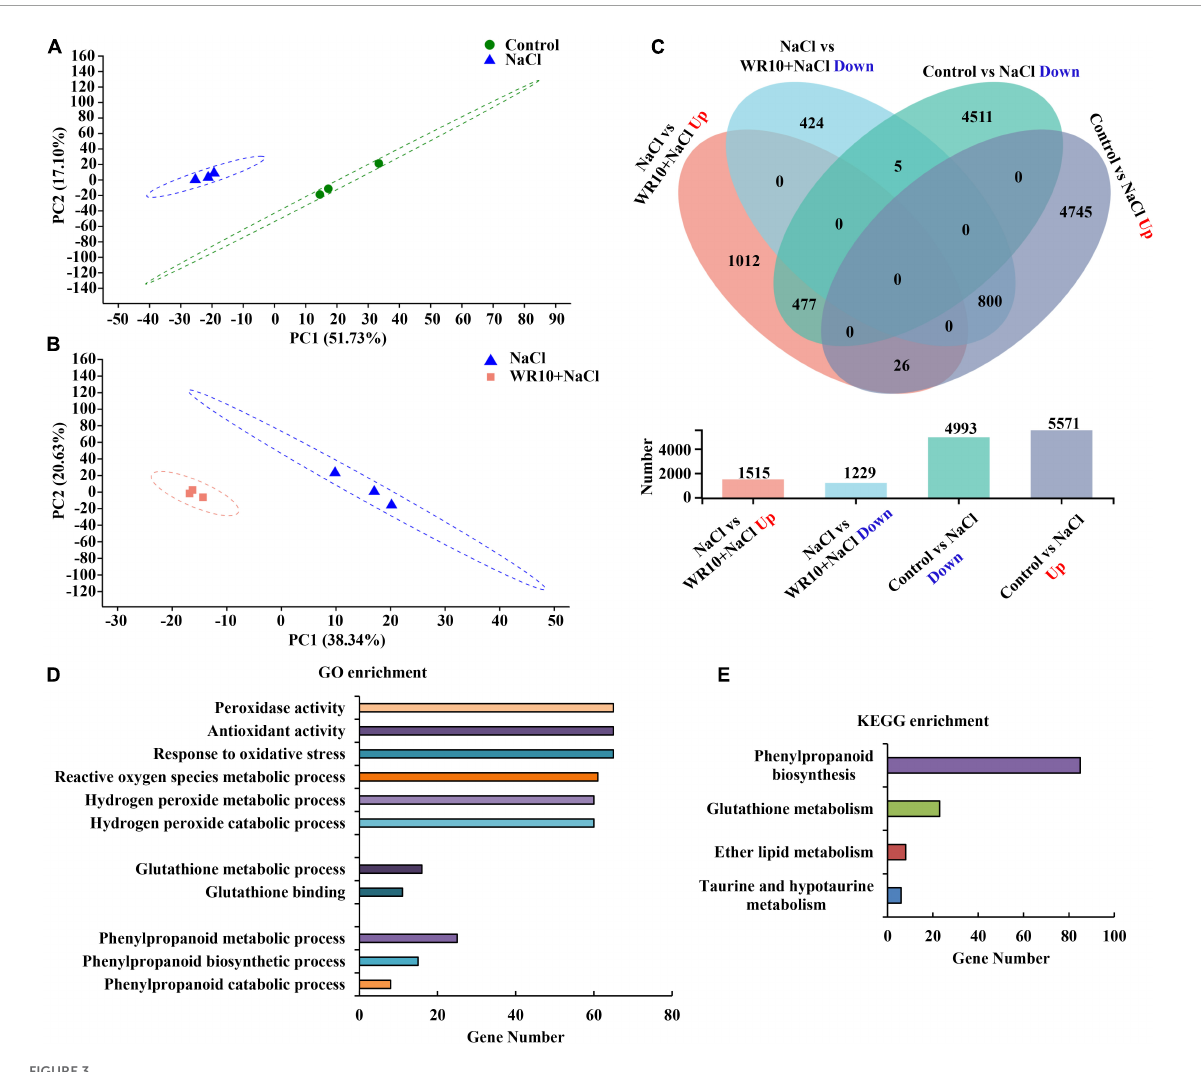
FIGURE3 RNA-sequencing analyses of wheat roots. (A) Principal component analysis (PCA) analyses of Control and NaCl groups. (B) PCA analyses of NaCl and WR10 + NaCl groups. (C) Venn diagram displaying the differentially expressed genes (DEGs) in Control vs. NaCl and NaCl vs. WR10 + NaCl. (D,E) GO and KEGG enrichment analyses of DEGs in NaCl vs WR10 + NaCl. Control, without NaCl and WR10; WR10, with WR10 and without NaCl; NaCl, with NaCl and without WR10; WR10 + NaCl, with NaCl and